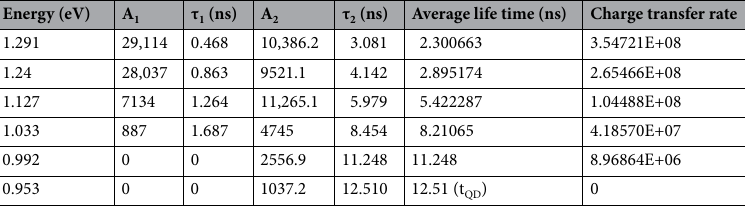
Table 1. Fitting parameters of TRPL data at each energy.